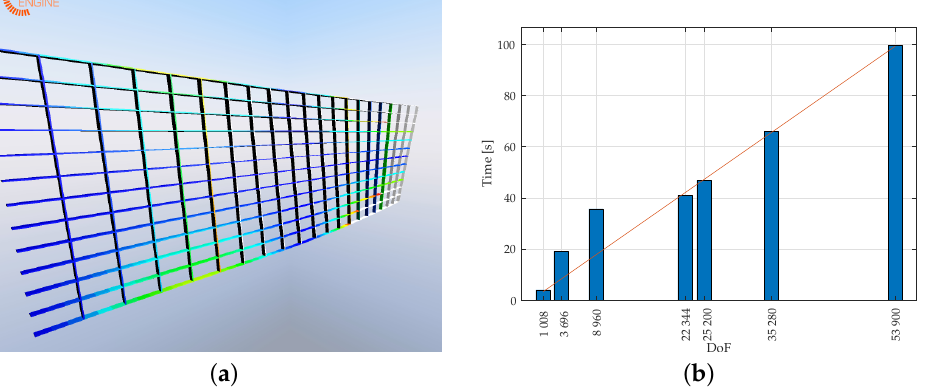
Figure 5. Scalability Test. ( a ) Beam Grid Model. ( b ) Beam Grid Time